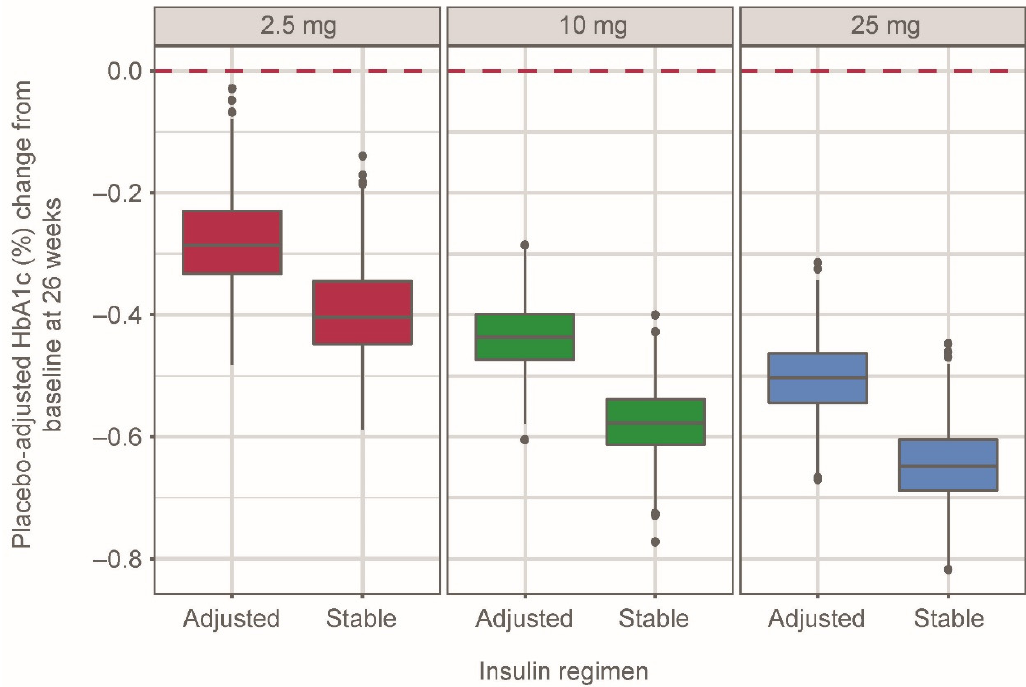
Figure 2. Placebo-adjusted simulated HbA1c (%) change from baseline at week 26 in 500 patients per empagliflozin dose group for each regimen, grouped by empagliflozin dose and insulin regimen using the semi-mechanistic model. Distributions represent simulated median values from 500 replicates. Whiskers represent 1.5 × interquartile range. Black dots indicate simulated data outside of 1.5 × interquartile range.